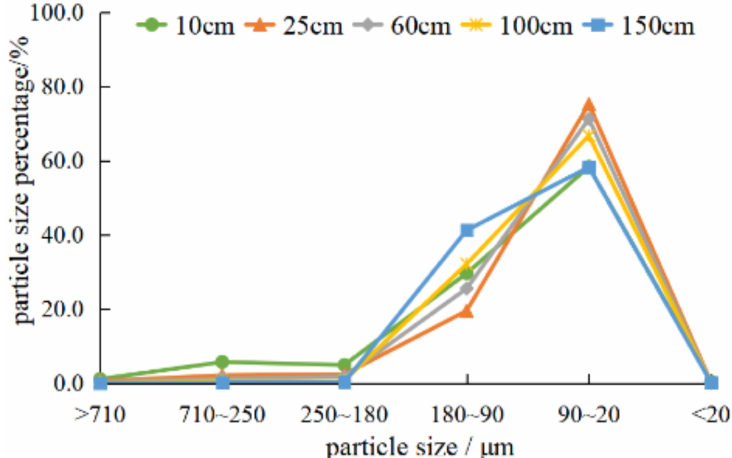
Figure 11. Yanqing straw mulching.